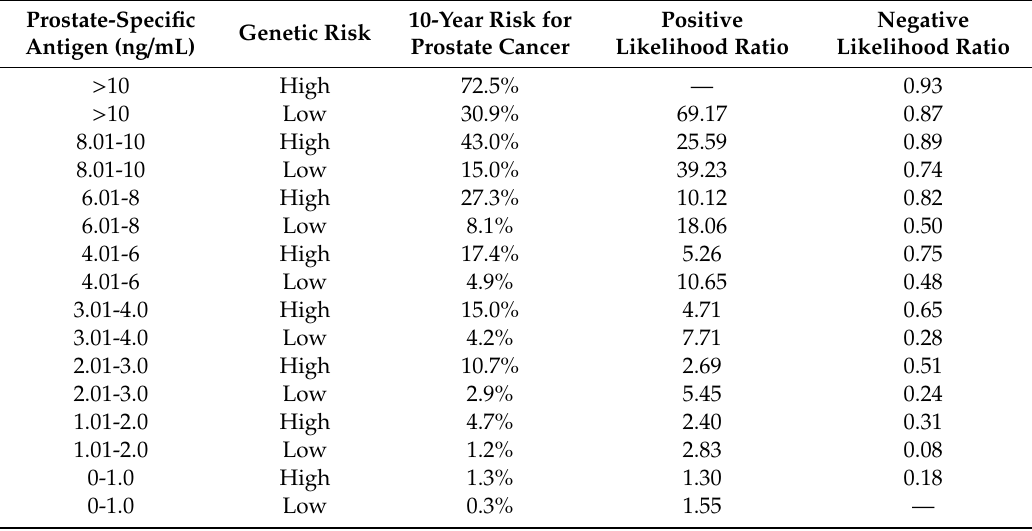
Table 2. The 10-year risk of developing prostate cancer, with the positive and negative likelihood ratios by PSA levels and genetic risk